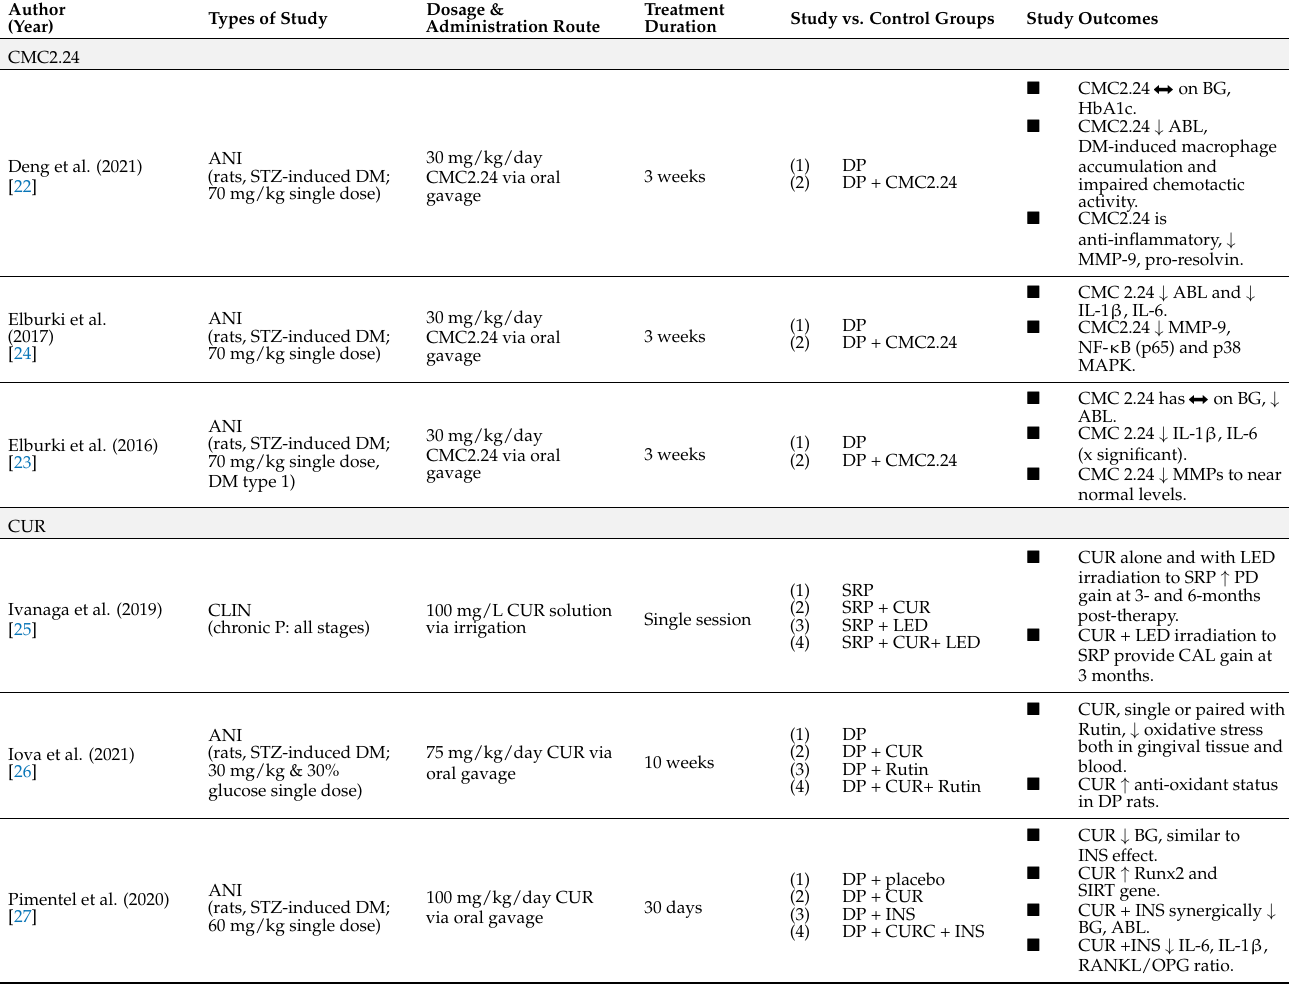
Table 3. Studies on the use of curcumin (CUR) in diabetes-associated periodontitis (DP).